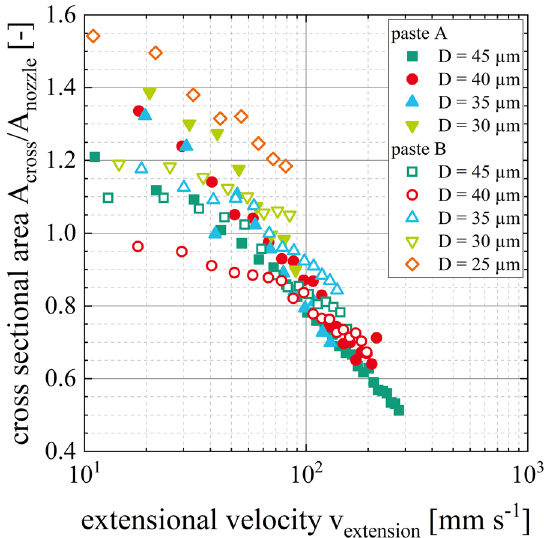
Figure 10. Correlation between elongation properties of the low-temperature curing Ag pastes A and B and the resulting electrode shapes. The ratio of cross-sectional area of the dispensed Ag-electrode A cross to the cross- sectional area of the nozzle A nozzle are plotted over the extensional velocity v extension